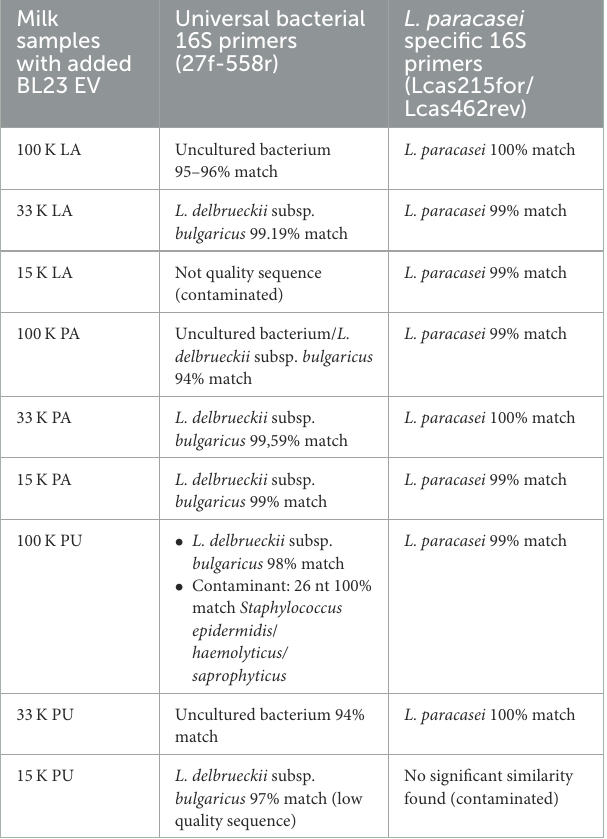
TABLE 4 Sequences obtained after the amplification of 16S rDNA from EV in the 100K pellets of the different fermented dairy products. Milk